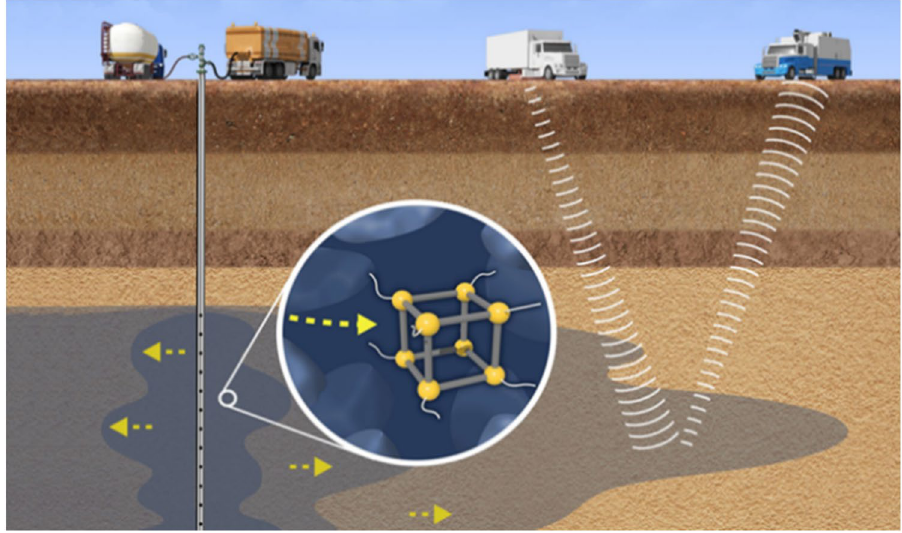
Figure 1. Illustration of low-frequency absorptive metal–organic frameworks acoustic nanomaterials injected into the subsurface to track fluids and map complex